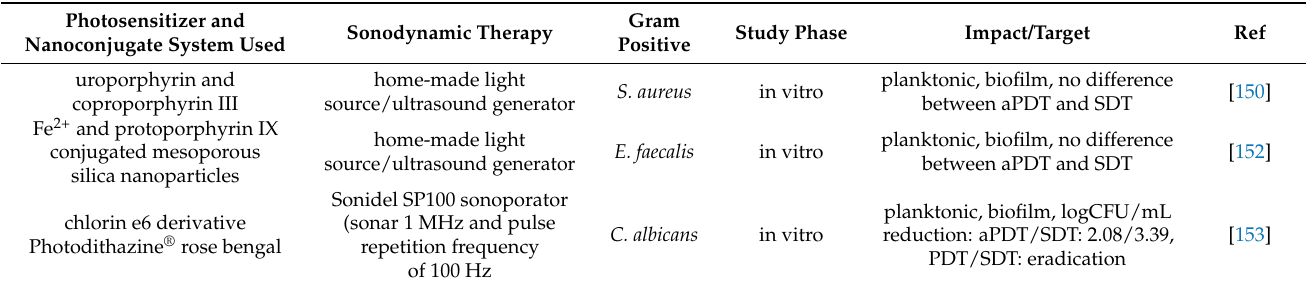
Table 7. Combination of antibacterial photodynamic therapy with sonodynamic therapy.